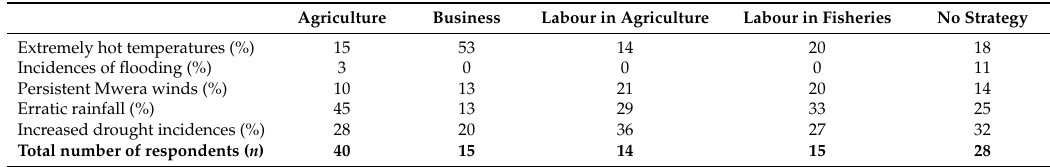
Table 1. Nkhotakota fishers’ ( n = 112) coping strategies to low fish catches matched with their perceived climate exposure. Agriculture Business Labour in